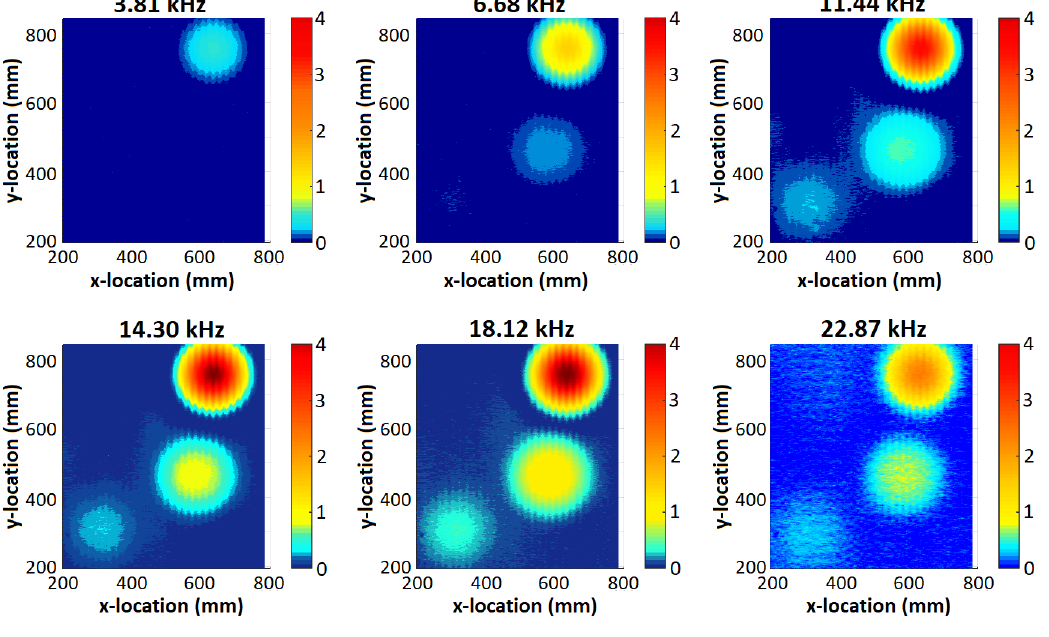
Figure 13. MIS test results—imaginary component.